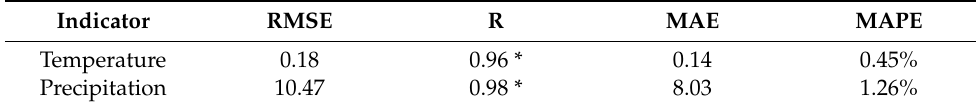
Table 1. The scores of each indicator in accuracy